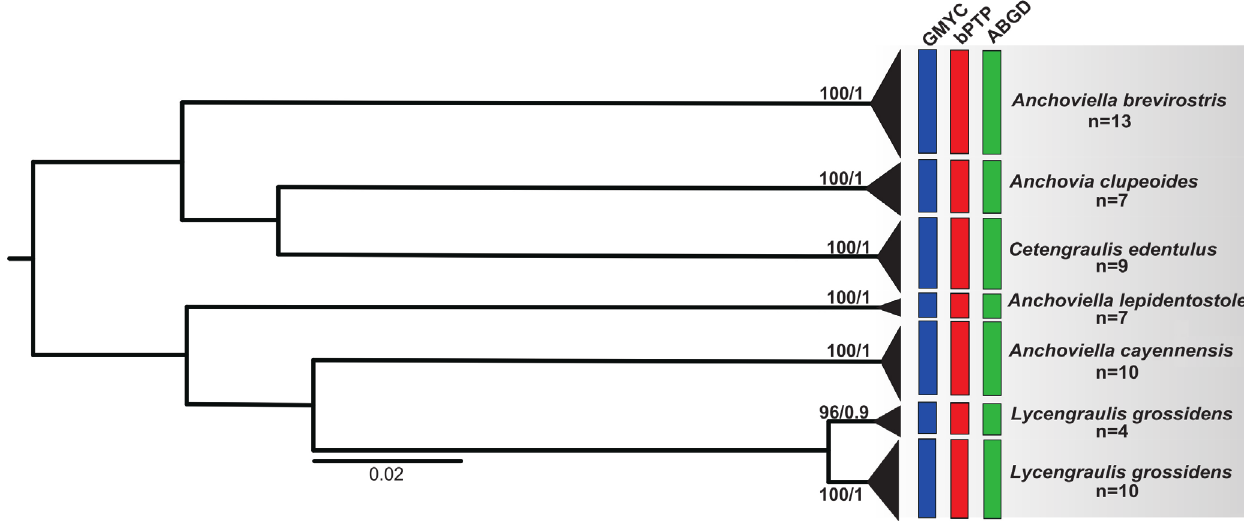
FIGURE 6 | Bayesian topology and species delimitation using Generalized Mixed Yule-coalescent (GMYC), Bayesian Poisson Tree Process (bPTP) and Automatic Barcode Gap Discovery (ABGD) discriminating species denominated